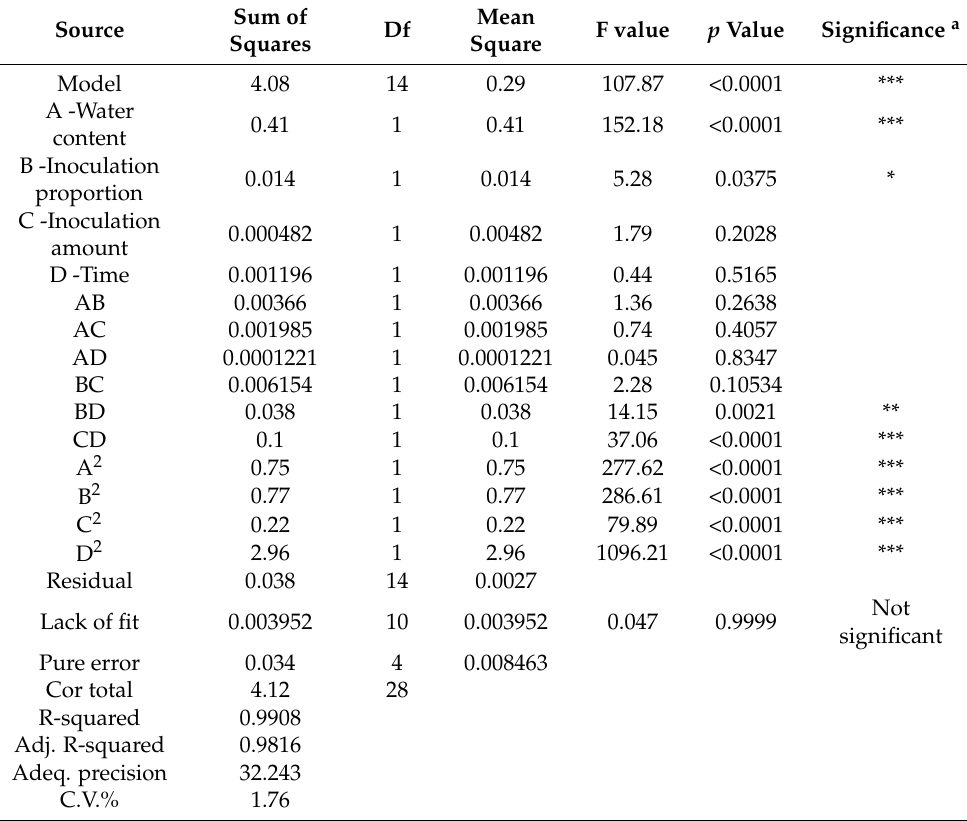
Table 3. ANOVA with the response face quadratic